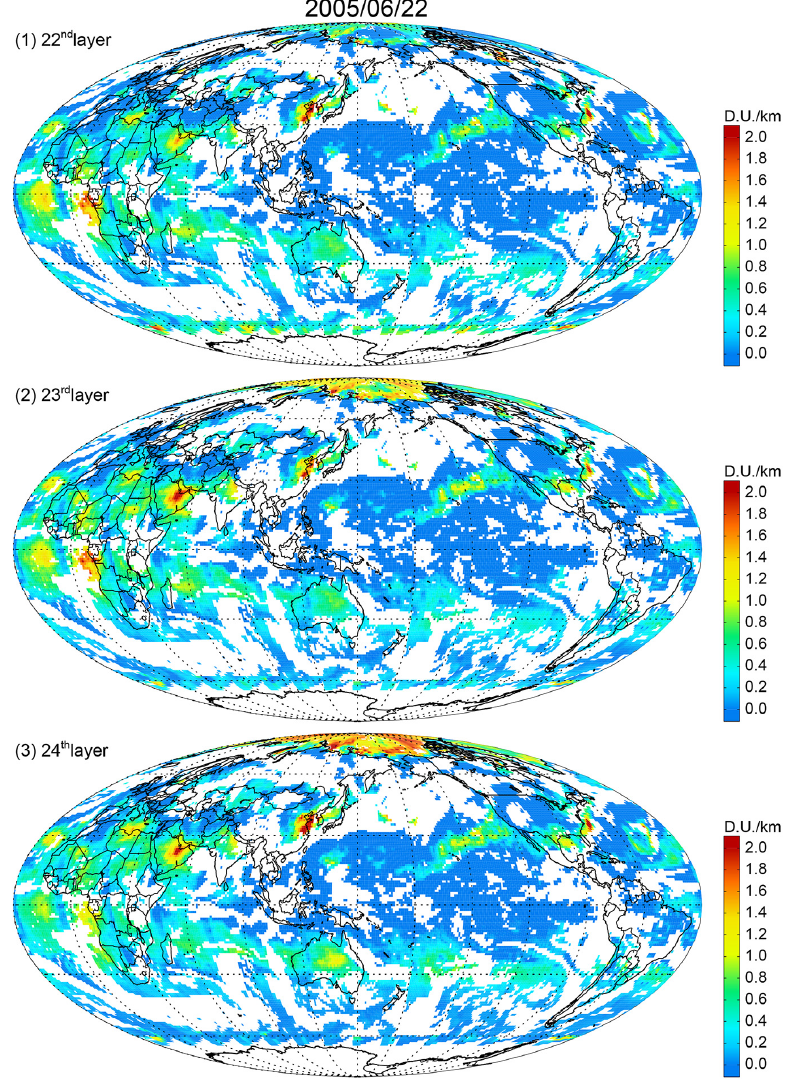
Figure 6. Global maps of (cid:49) O 3 observed by OMI at the (1) 22nd, (2) 23rd, and (3) 24th layers on 22 June 2005, which correspond to the MOZAIC measurement shown in Fig. 2. The unit of ozone amount is noted by DUkm − 1 . Cloudy areas were screened out with the criteria of ECF < 0.2 and data quality as RMS < 2.4 (shown in